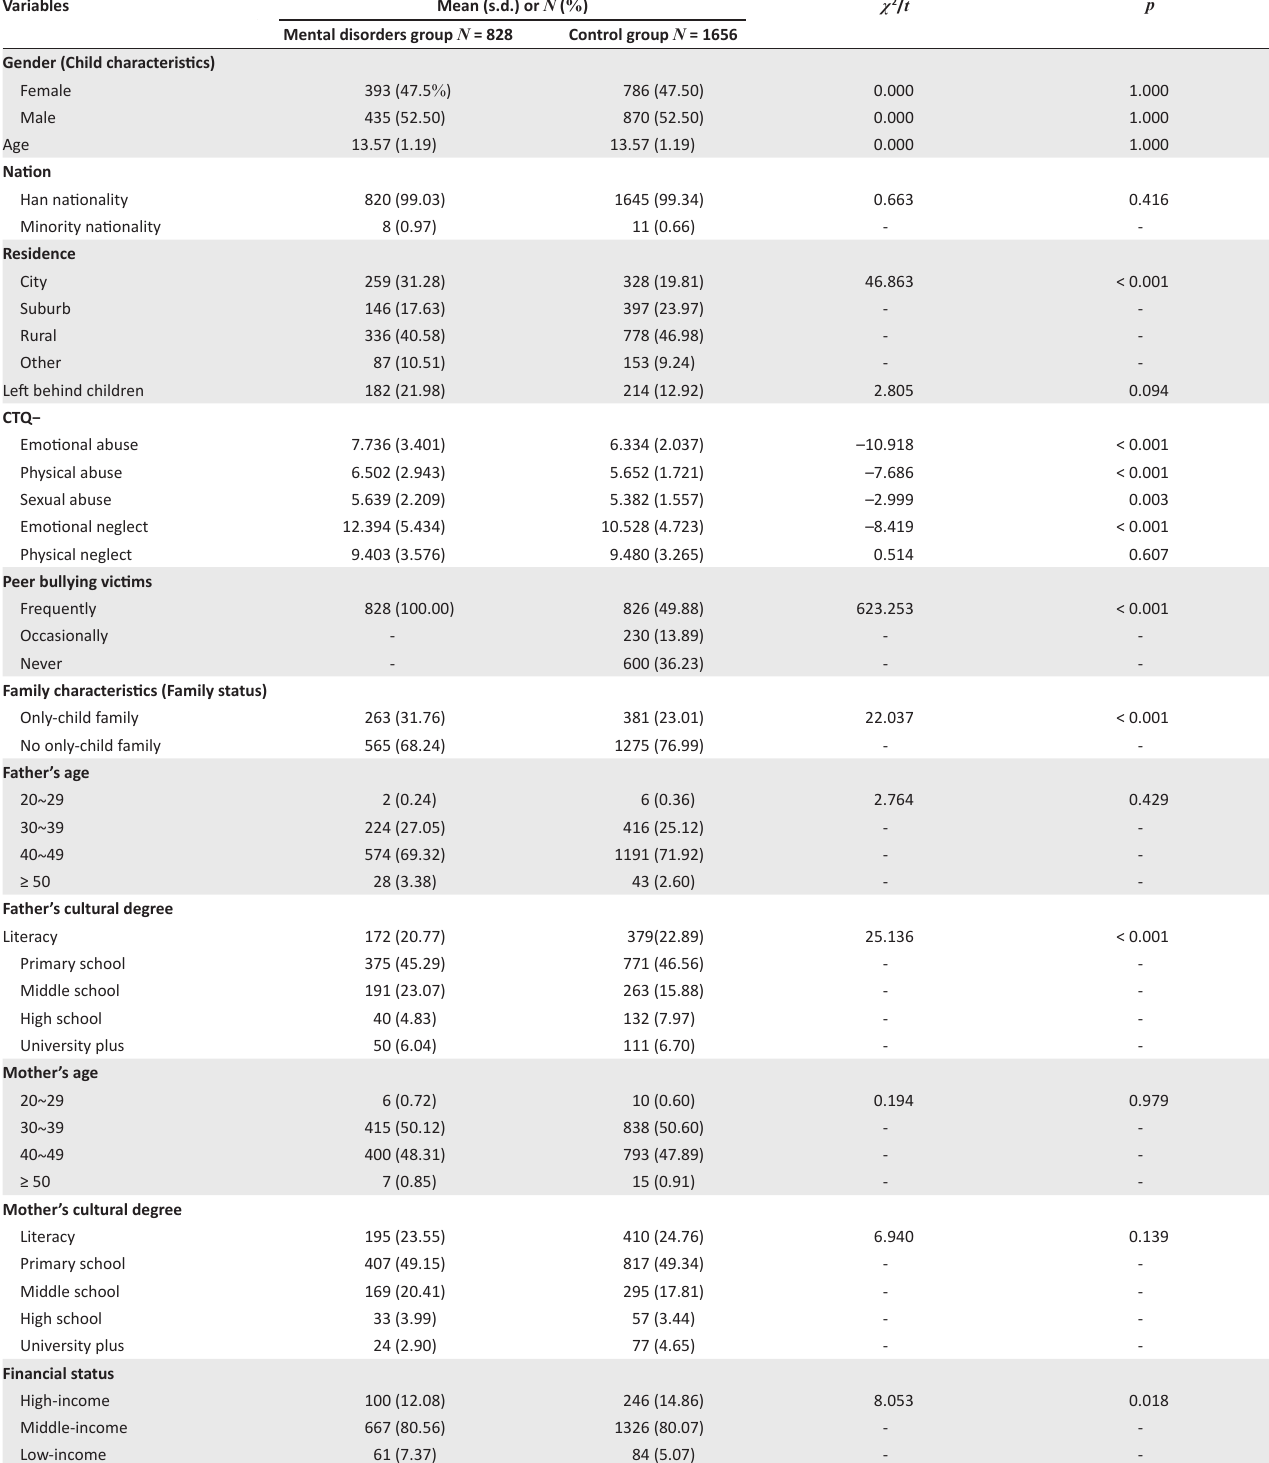
TABLE 1: Demographic characteristics of the two groups sample (the mental disorders group and the control group).